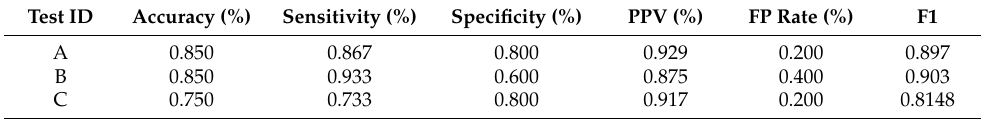
Table 6. Summary of automatically generated decision tree metrics for LIDC-IDRI images.